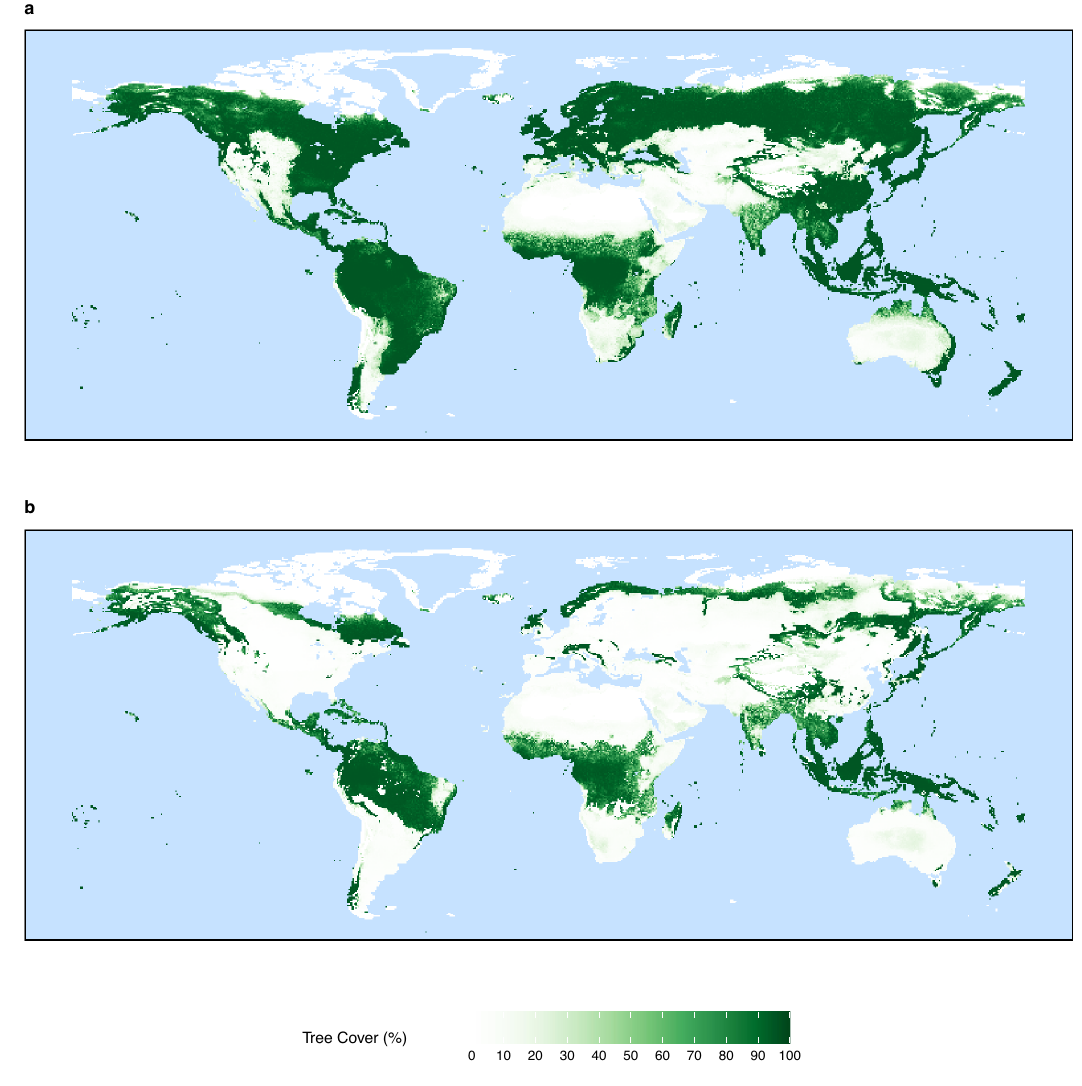
Fig. 1 | Globaltreecover. Takenasa 10-yearannualaverage from thelast decade ofLPJ-LM fi refor a present-daylevelofatmosphericoxygen(20.95%)and b 35% vol.O 2